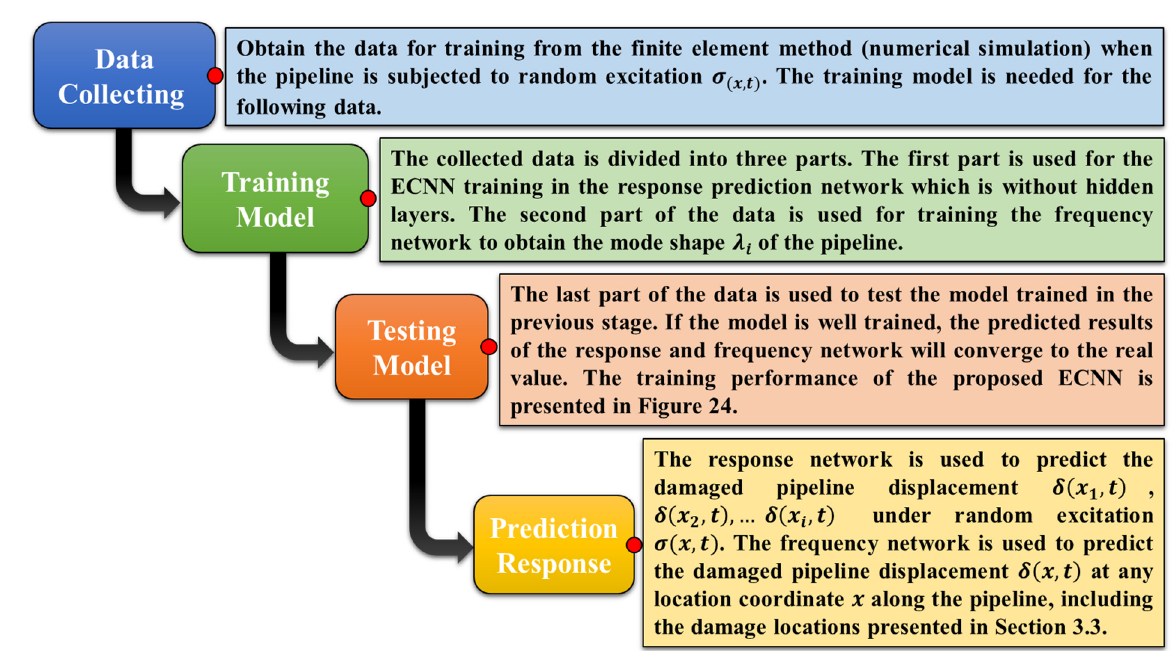
Figure 23. The steps of ECNN development.